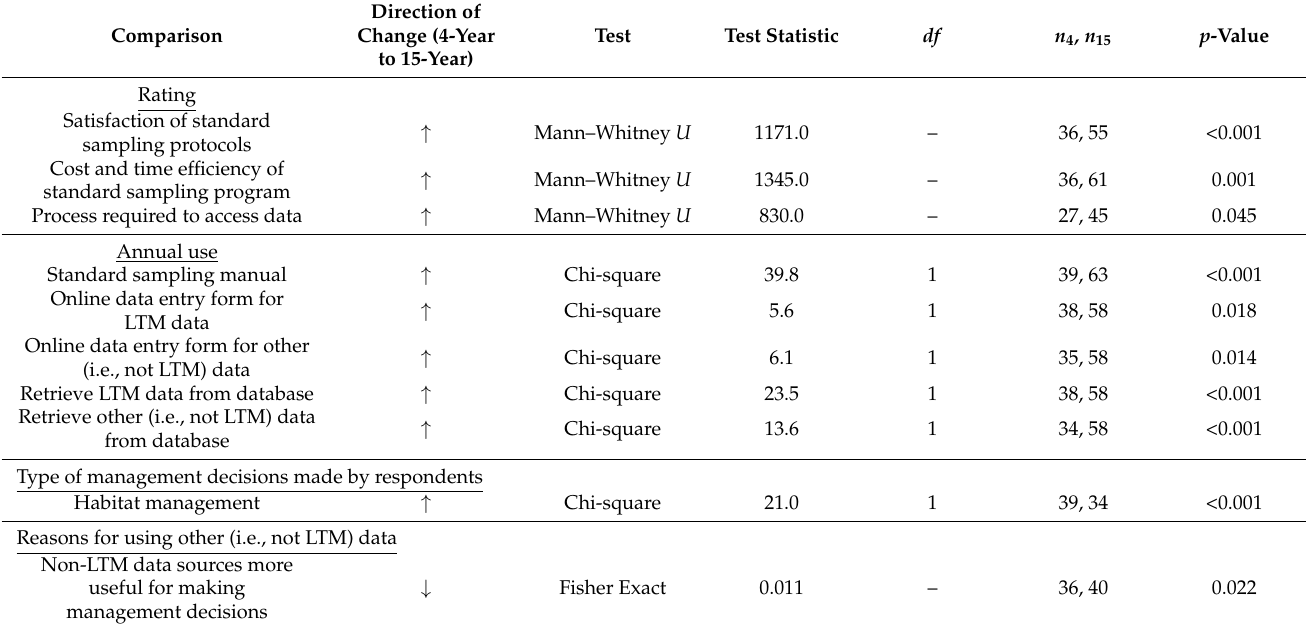
Table 4. Temporal comparison of ratings of Florida’s statewide Freshwater Fisheries Long-Term Monitoring (LTM) program between the 4-year and 15-year surveys. Ratings range from 1 [very poor] to 5 [very good]), whereas annual use, type of management decisions, and reasons for using other (i.e., not LTM) data have binary responses (either 0 [option not selected or not typically used] or 1 [option selected or typically used]). The table includes the direction of change between the 4-year and 15-year surveys (increase [up arrow], decrease [down arrow]), statistical test, test statistic, degrees of freedom ( df ), number of respondents to the 4-year survey ( n 4 ) and 15-year ( n 15 ) surveys, and p -value. Comparisons show moderate to strong evidence of change ( p < 0.049). Only comparisons considered to have broad applicability are shown